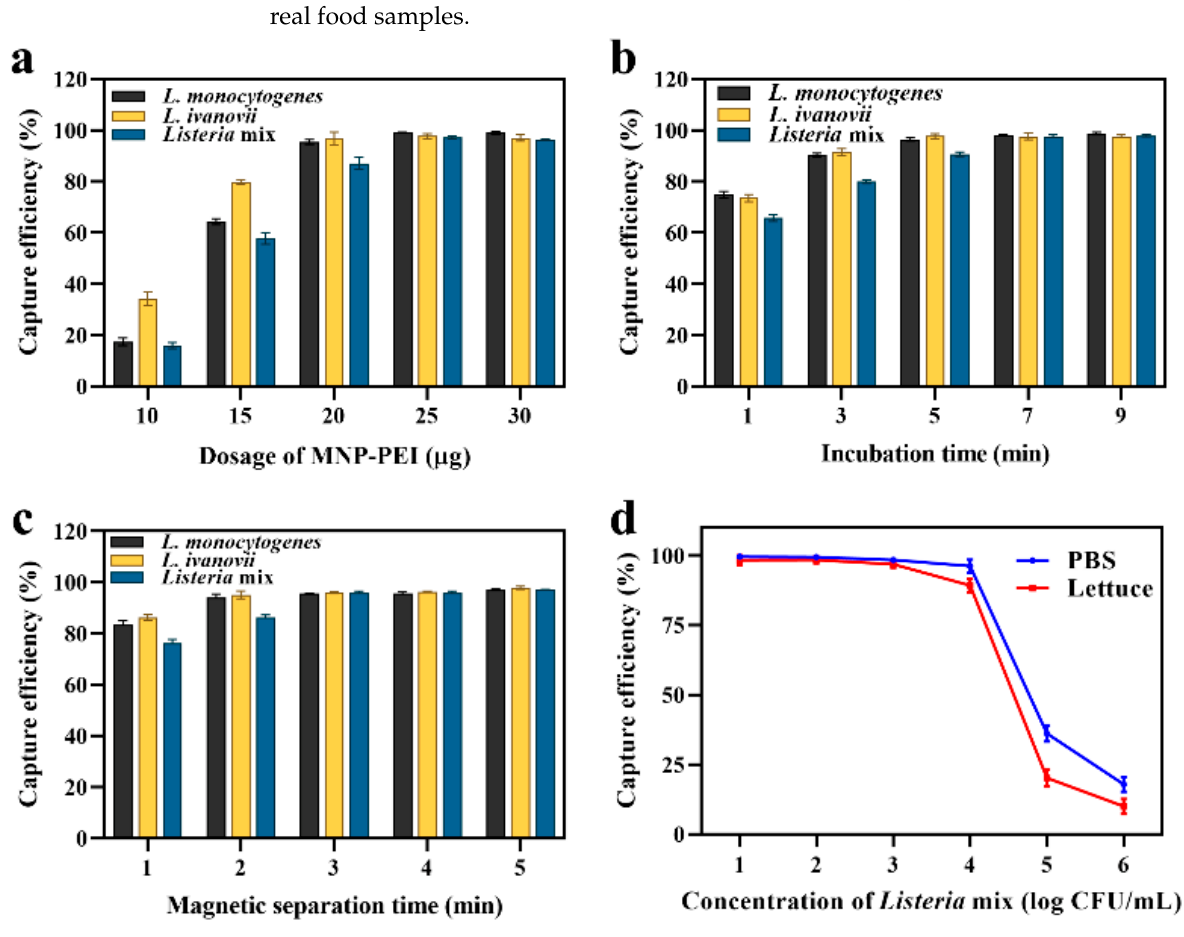
Figure 4. Optimization of experimental parameters. ( a ) Dosages of PEI-MNPs. ( b ) Incubation time of PEI-MNPs bound to Listeria . ( c ) Magnetic separation time of Listeria -PEI-MNPs complexes. ( d ) CE of pathogenic Listeria spp. at the concentrations from 10 1 CFU/mL to 10 6 CFU/mL by PEI-MNPs in PBS and lettuce.